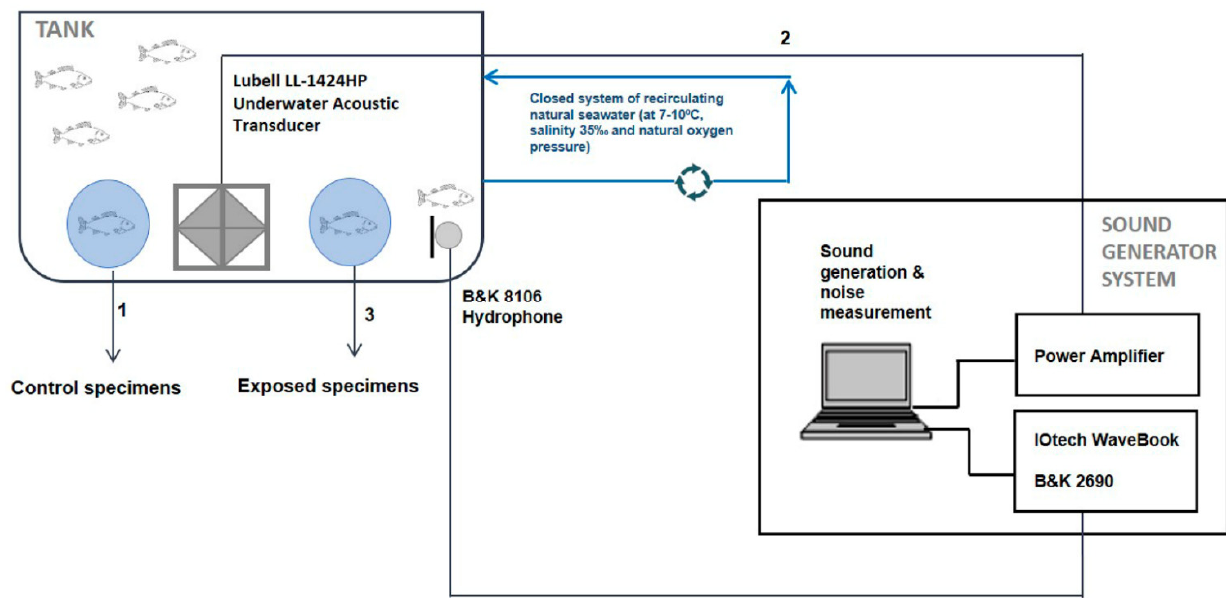
Figure 1. Sound exposure protocol, sampling collection, and analysis. (1) After 2 weeks of acclimation, 10 salmon were taken for sample analysis as controls previous to the sound exposure. (2) Forty salmon were exposed to sound (Weeks 1, 2, 3:2 cycles [350 Hz (65 V-2 h) and 500 Hz (65 V-2 h)], daily with 2 h rest in between two cycles. Week 4:3 cycles [350 Hz (65 V-2 h) and 500 Hz (65 V-2 h)], daily with 2 h rest in between two cycles). (3) Samples of exposed salmon were sequentially taken for analysis after exposure (week 1 to 4).